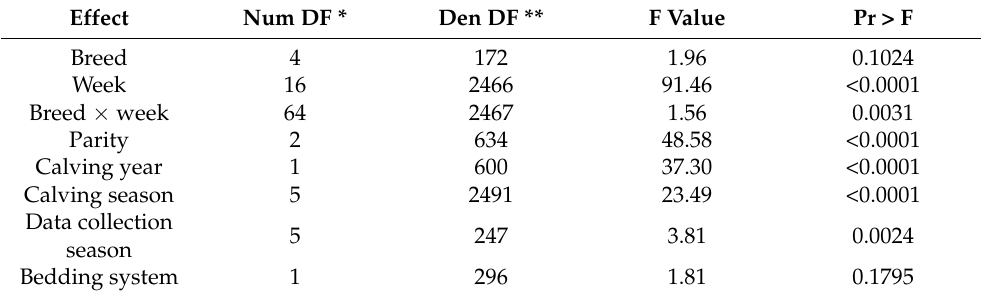
Table A2. Variance analysis results for the variable back fat thickness (BFT).